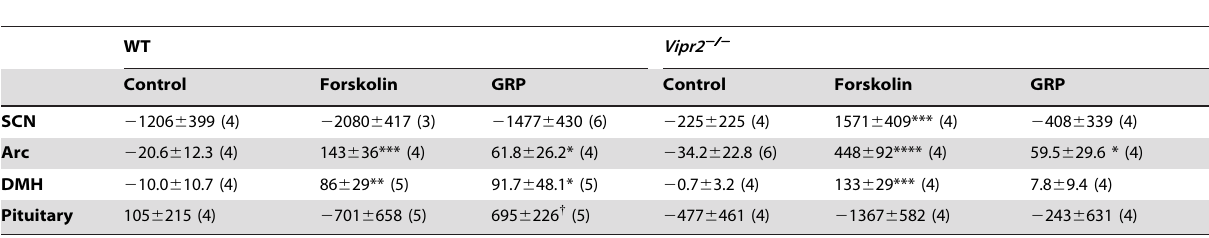
Table 2. Bioluminescence Amplitude Data for Responses of WT and Vipr2 2 / 2 Tissues to Control and GRP Treatments.